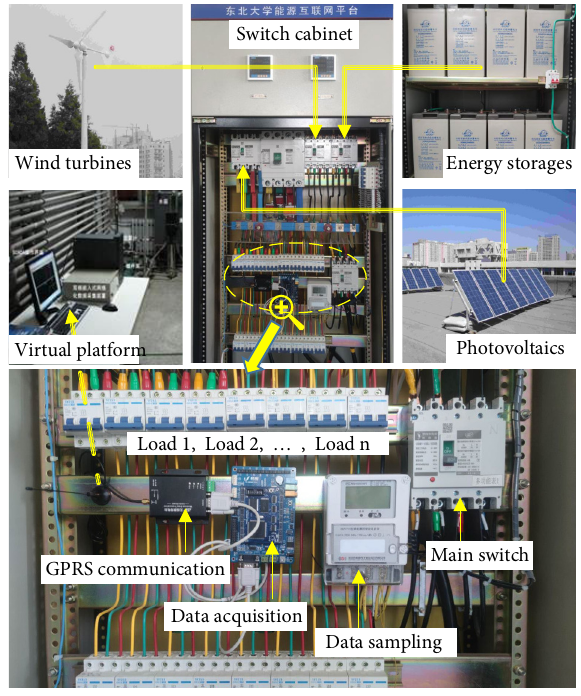
Fig. 2 Topology diagram of experimental